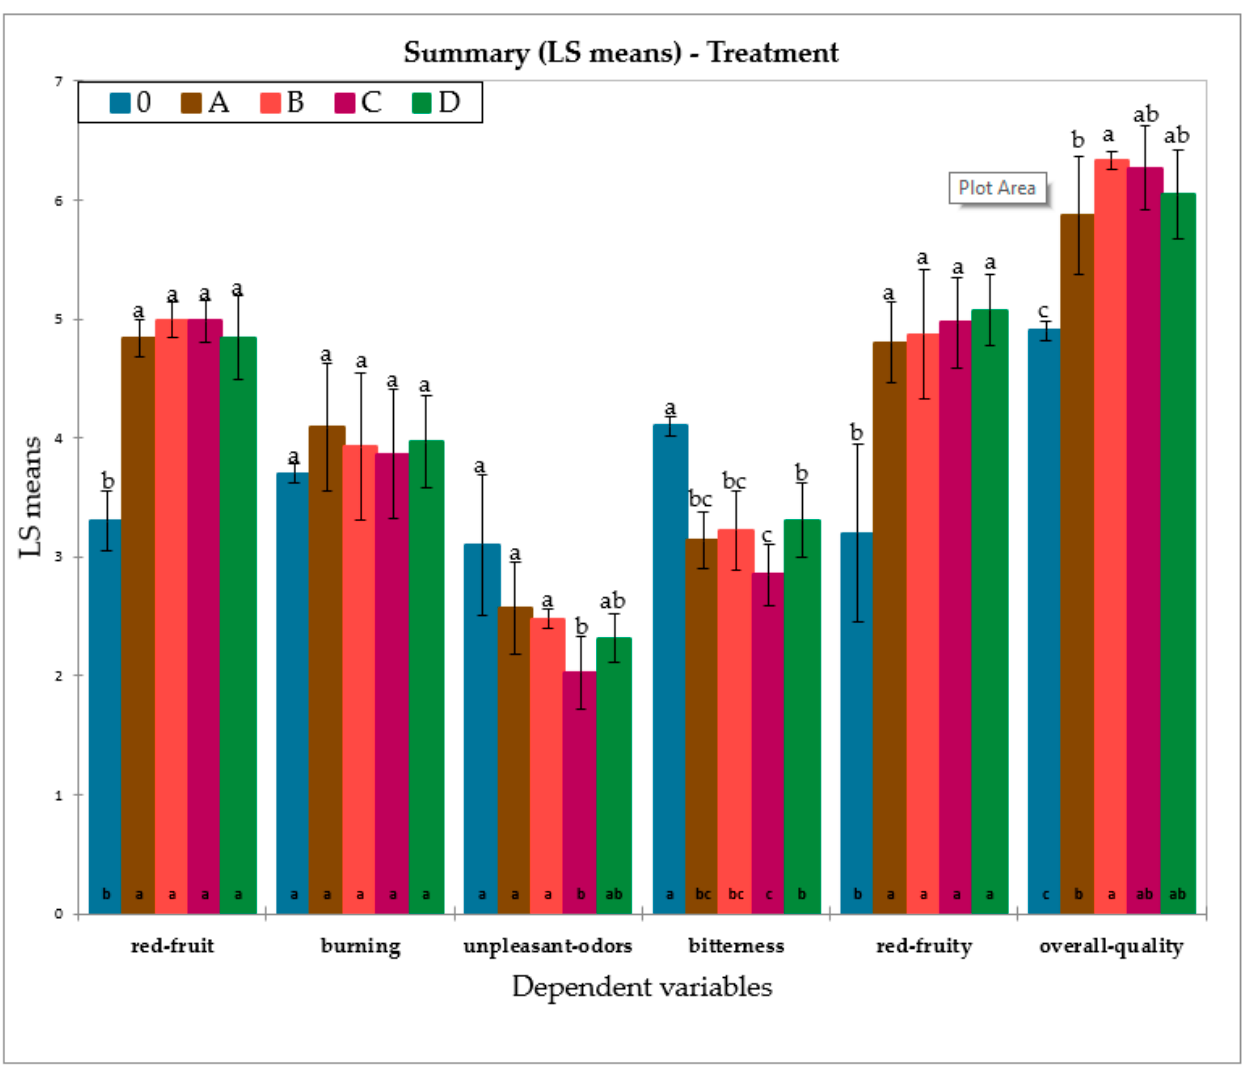
Figure 5. Bar chart plot for the significant variables in the one ‐ way ANOVA with Duncan’s post hoc test. A, B, C, and D indicate the applied treatments (see Figure 1 for details). 0 indicates samples at time 0. Lower case letters (a, ab, b, bc, c) represent the computed groupings of the groups by the Duncan’s post hoc multiple range test.